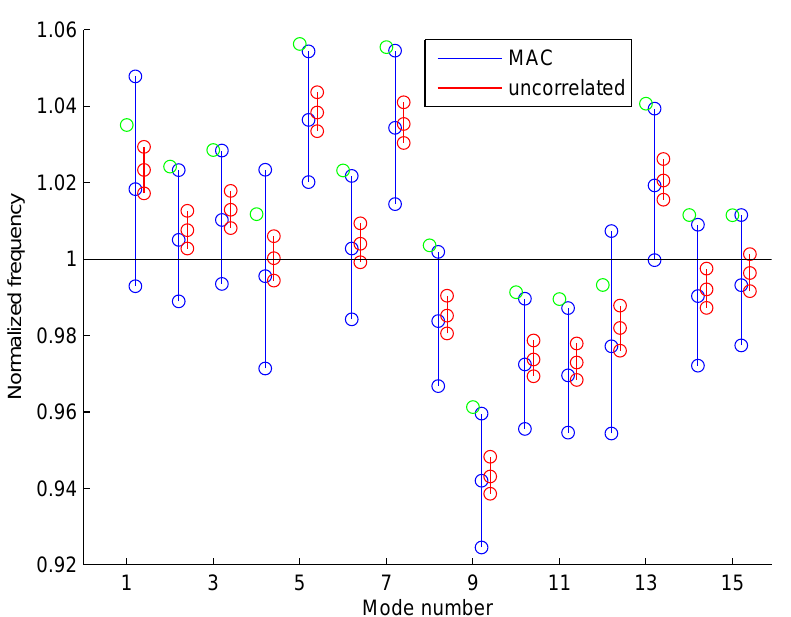
Figure 9. Posterior robust predictions for the modal frequencies normalized by the experimental modal frequencies under the vector-based (uncorrelated) and MAC-based formulations for the likelihood. Vertical lines (with three circles) for each mode number show the 5%, 50% and 95% quantiles. The isolated green circles show predictions from the nominal FE model.